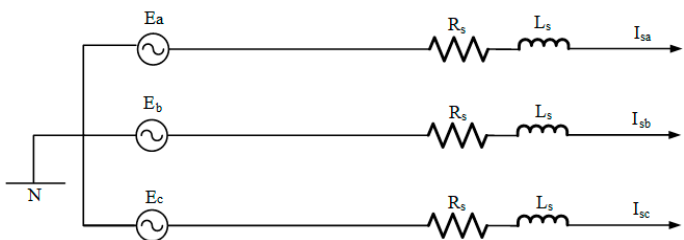
Figure 1. The equivalent circuit of healthy permeant magnet synchronous generator (PMSG) in the abc-frame.